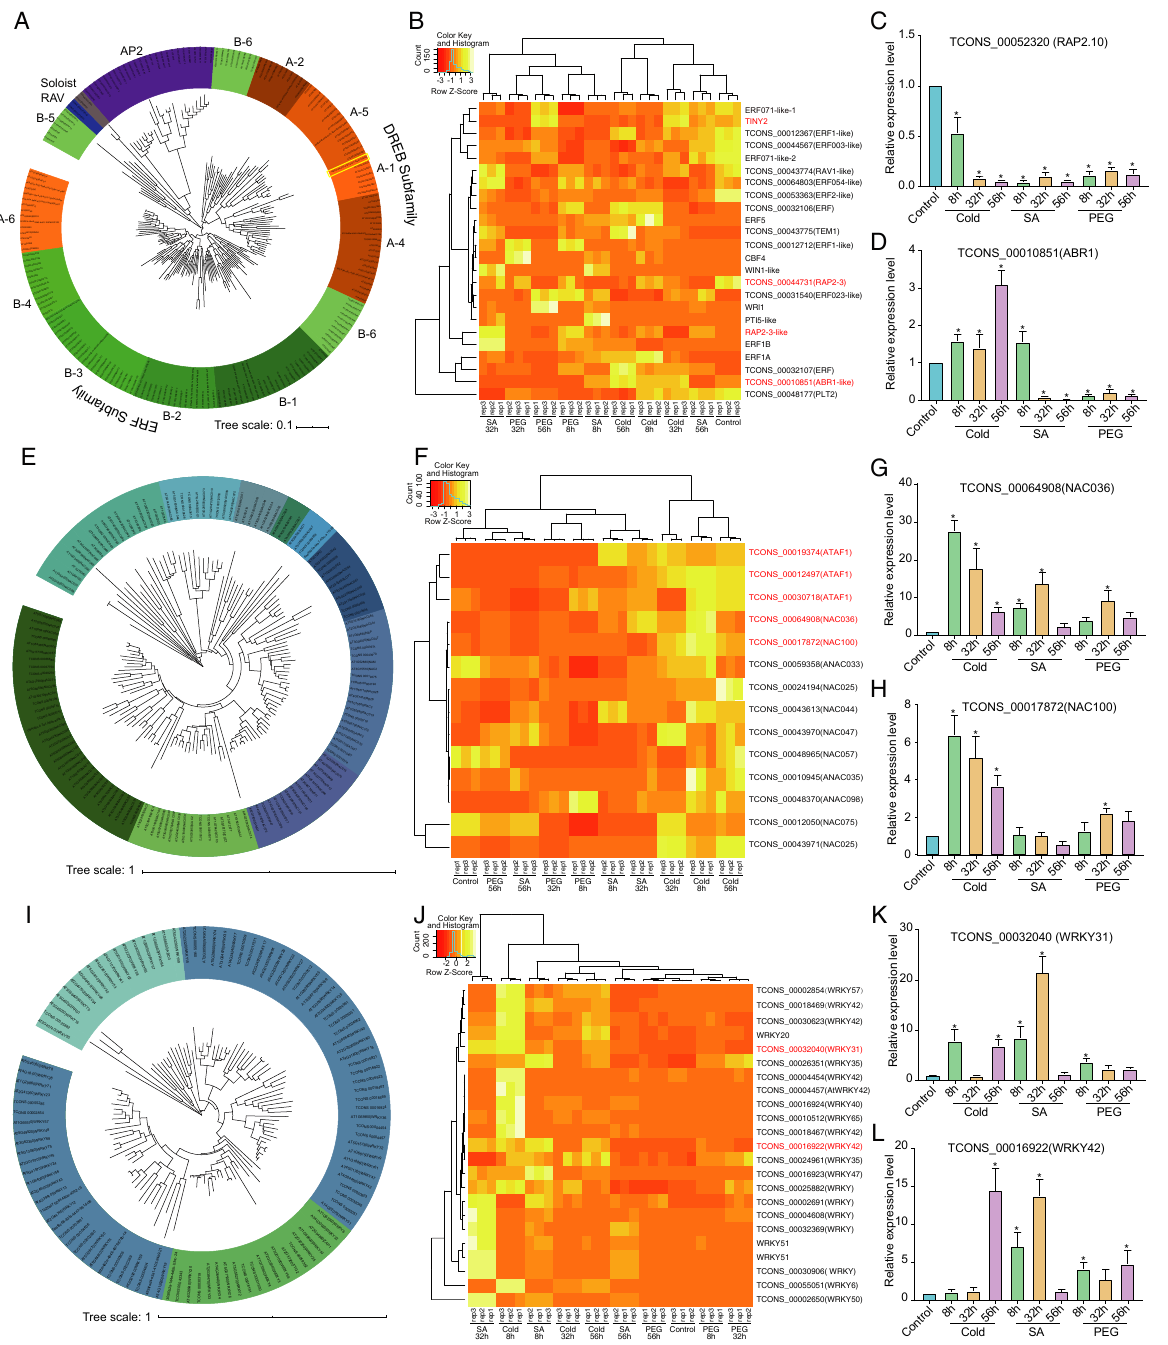
Figure 5. Systematic evolution analysis and differential expression of TFs under stress